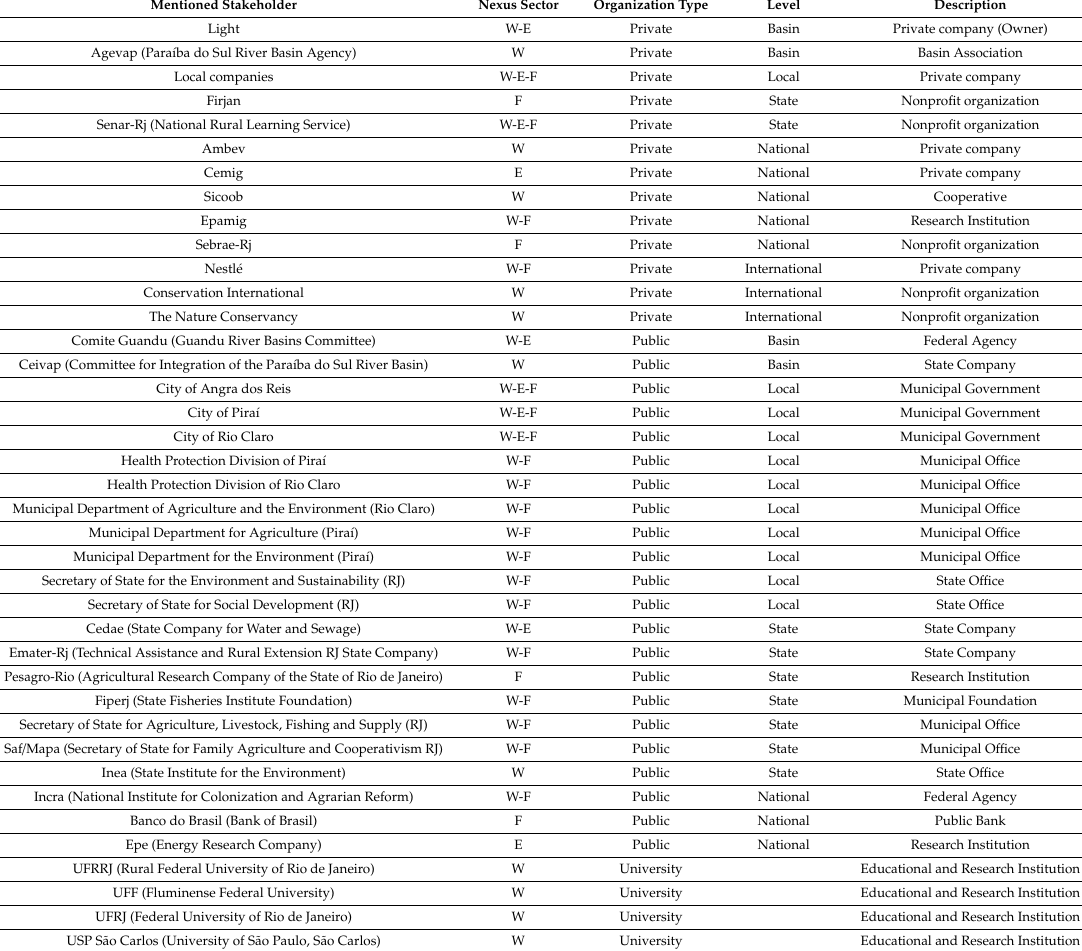
Table 2. List of stakeholders by Nexus sector of interest, type of organization and level of